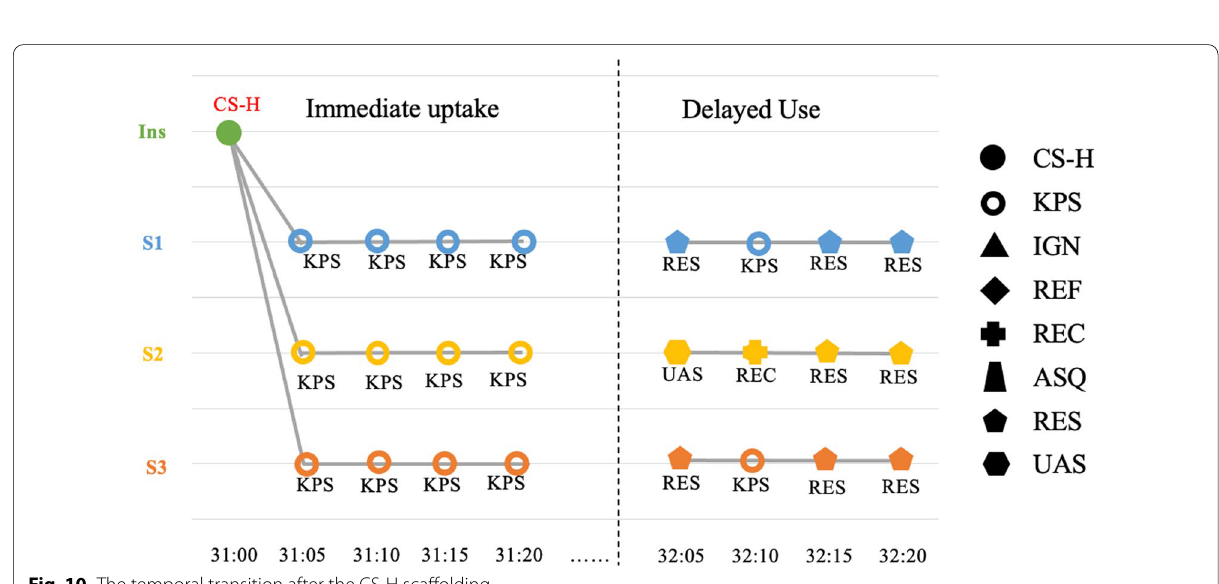
Fig. 10 The temporal transition after the CS-H